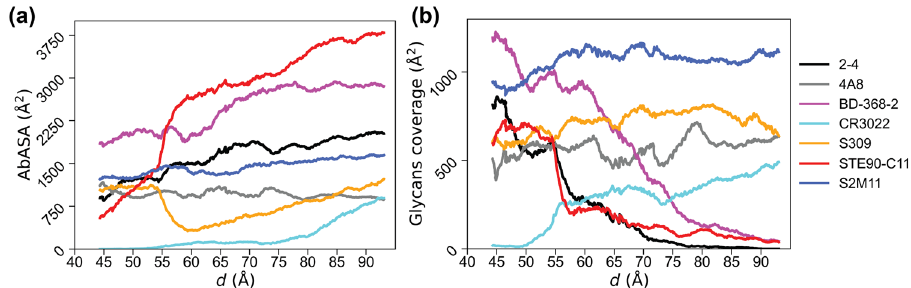
Fig. 6 Epitope analysis for selected antibodies. a Exposed area on antibody epitopes (AbASA) in the presence of protein and glycans. b Surface area of epitopes covered by glycans along the MEP quanti fi ed by subtracting the two AbASA values calculated with and without glycans. All accessible surface area calculations were performed using a 7-